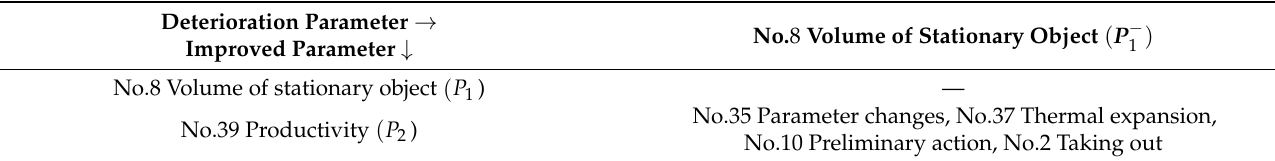
Table 11. Invention principles corresponding to conflicts of “Unable to dispense TCM continuously”.